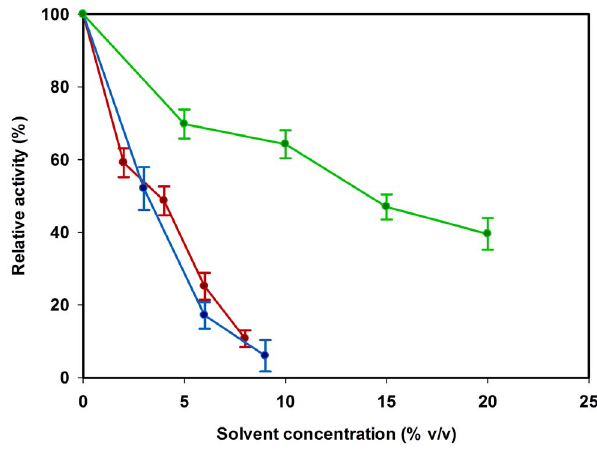
Figure 6. Ta AlDH activity in the presence of different organic solvents. Refolded Ta AlDH was incubated at 50 u C for 30 min in 100 mM HEPES pH 7 containing various concentrations of ethanol (green), isobutanol (blue) or n-butanol (red). Remaining enzyme activity was tested at 50 u C in respective incubation buffers.